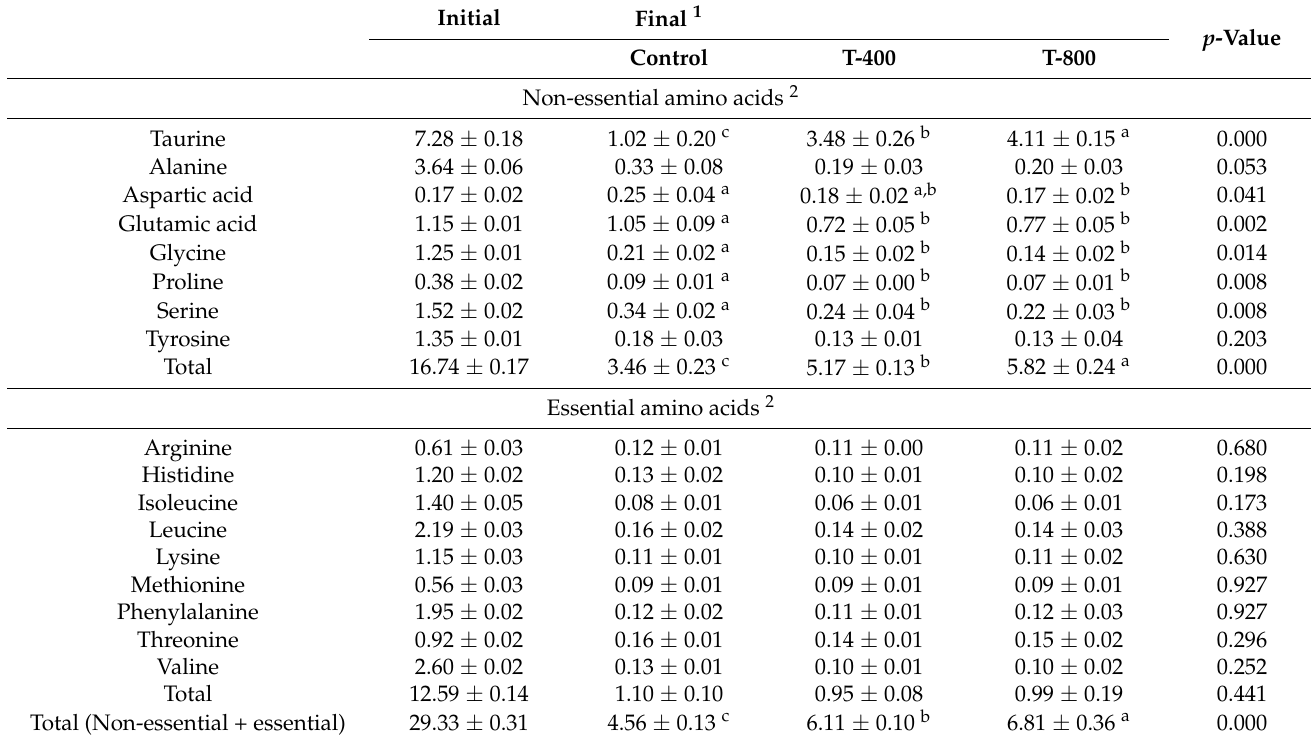
Table 4. Free amino acid content of small yellow croaker larvae fed with the various taurine-en- riched rotifers for 15 days (mg/g, dry-matter).